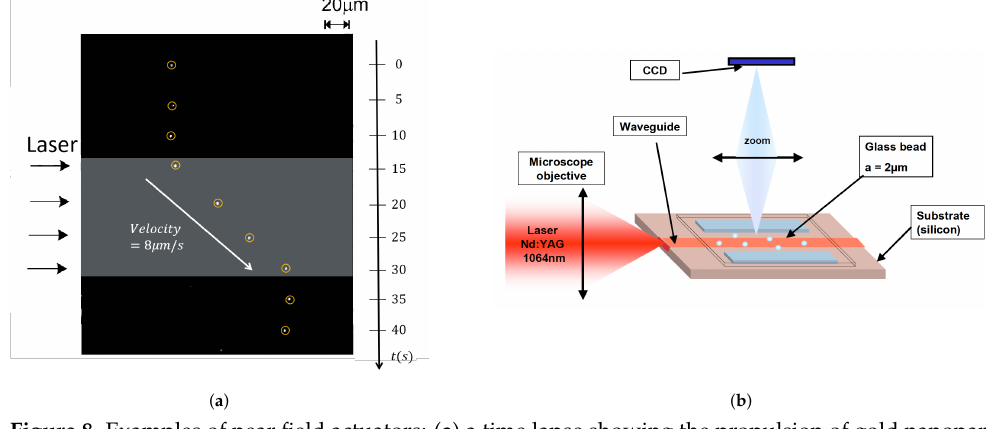
Figure 8. Examples of near field actuators: ( a ) a time lapse showing the propulsion of gold nanopar- ticles (highlighted in yellow circles), at a velocity of 8 µ m/s. Adapted, with permission from [53] © 2002 Elsevier, ( b ) the setup for the manipulation of dielectric nanoparticles on the surface of a silicon nitride waveguide. Reprinted with permission from [59] © The Optical